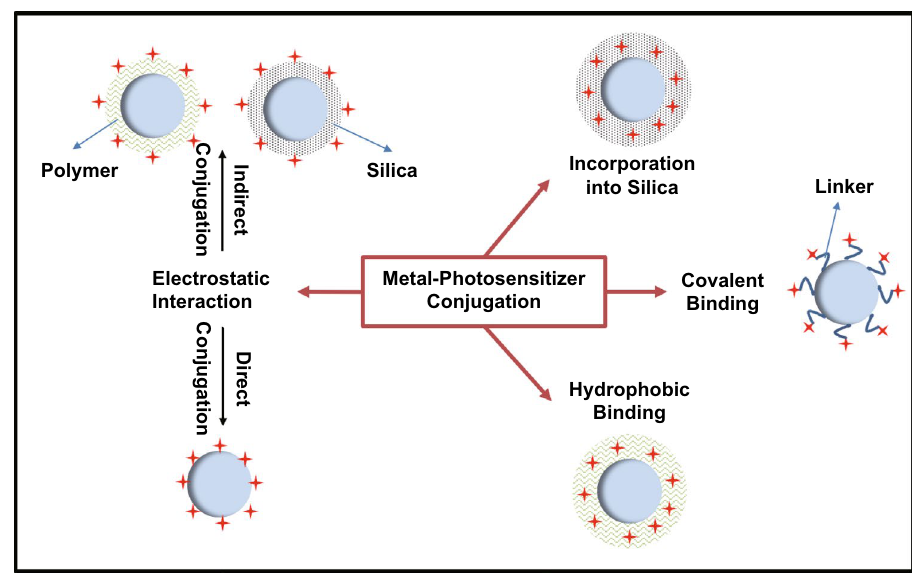
Fig. 12 Conjugation methods of photosensitizers molecules to the metal nanoparticles in forming colloidal metal-PS system for metal-enhanced singlet oxygen